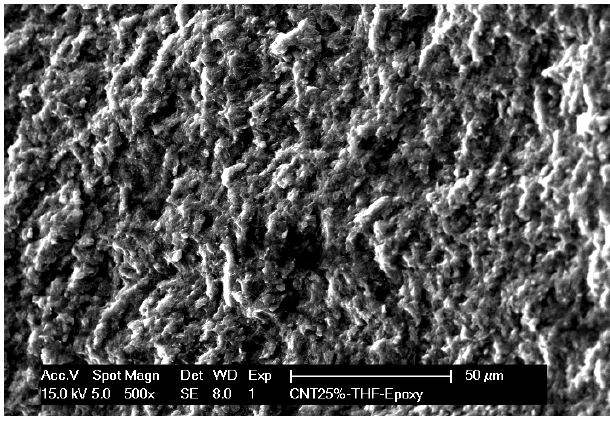
Figure 2. SEM image of MWCNT-EP composite